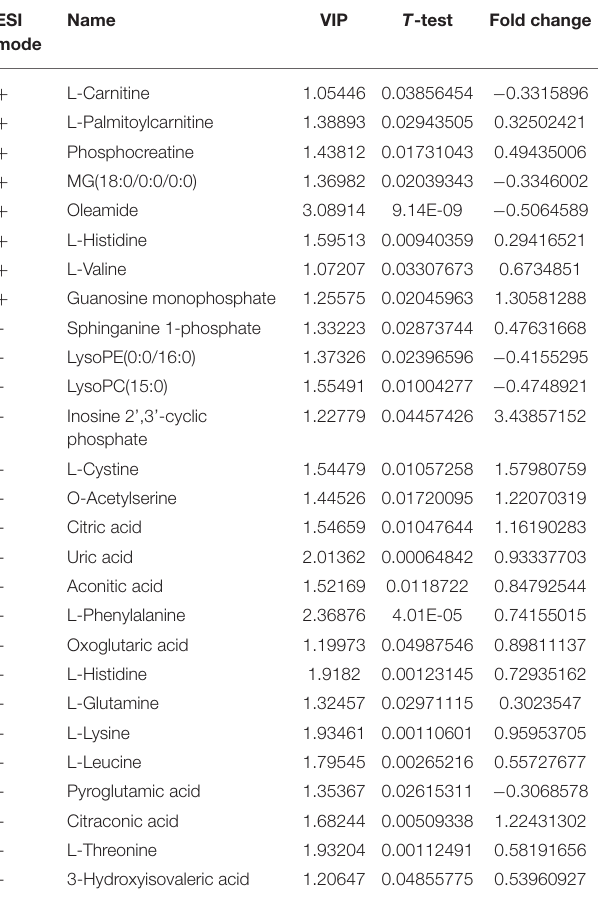
TABLE 2 | Differential Metabolites between preoperative samples of non-POCD and POCD group.